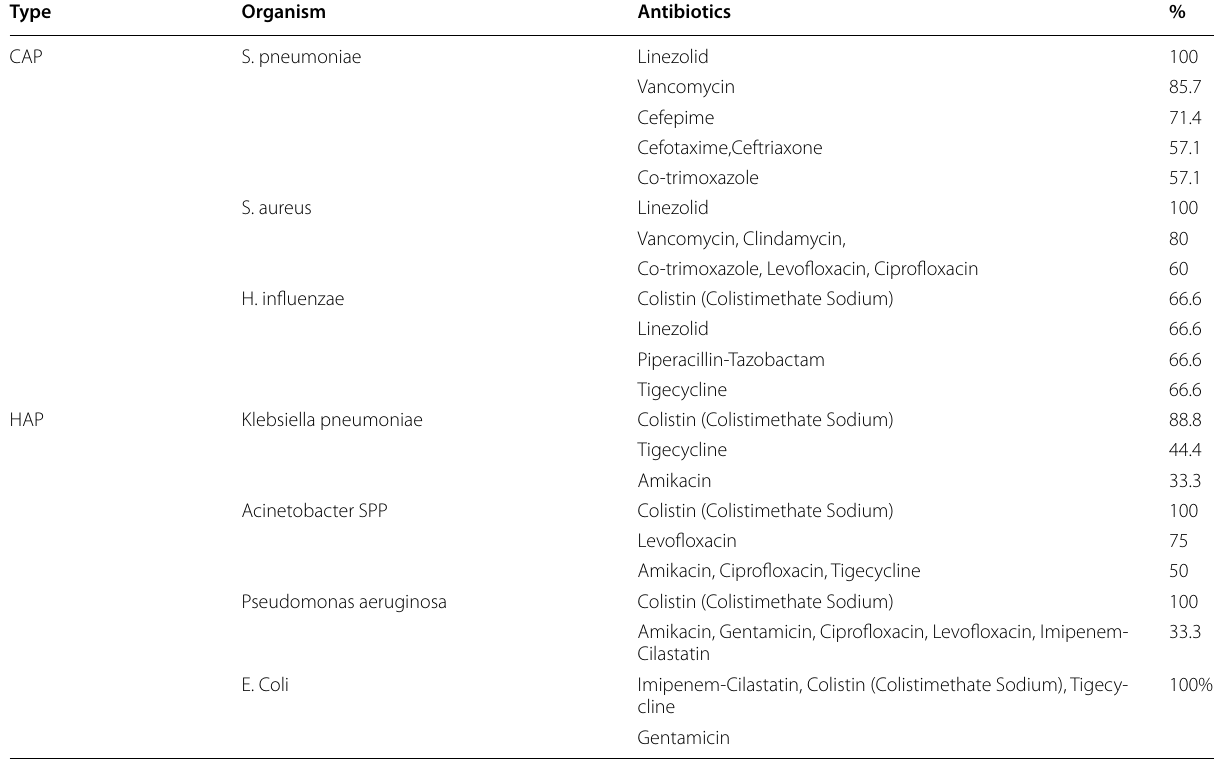
Table 5 Distribution of antimicrobial senstivity according to the causing bacterial pathogen and pneumonia